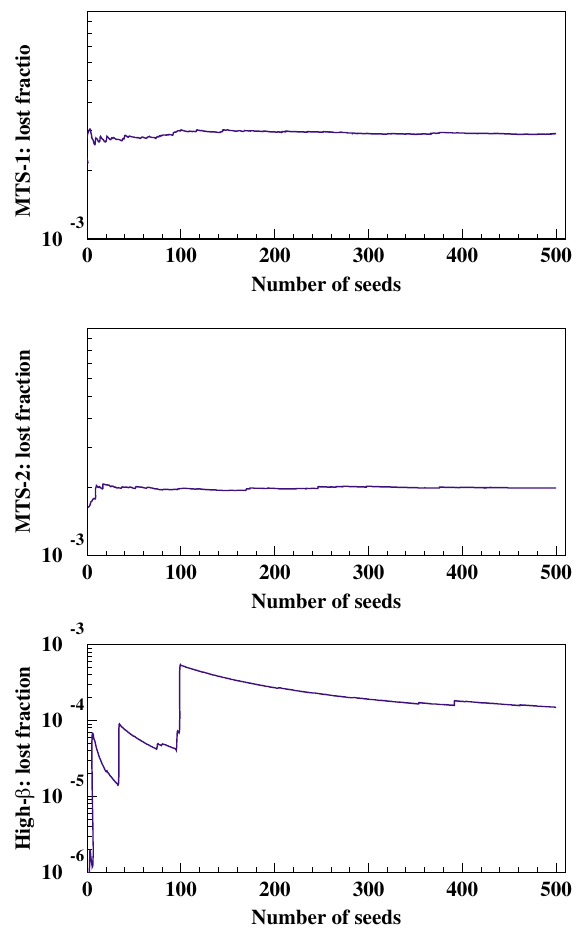
FIG. 15. (Color) Evolution of beam losses as a function of the number of error sets or seeds of random numbers. Calculated for the ECL design and the error combination 4 of Table